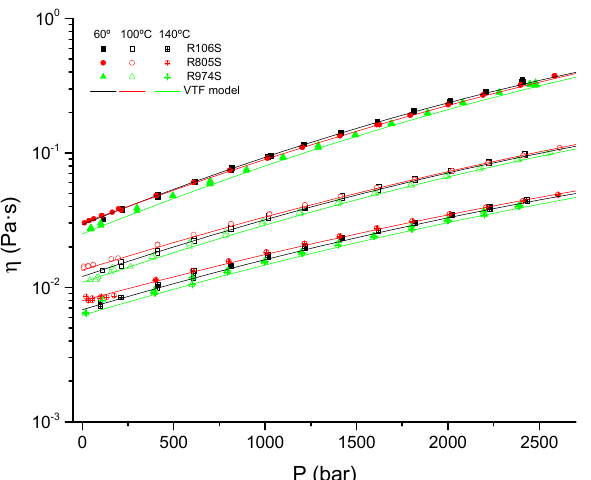
Figure 7. Pressure-viscosity curves for fumed silica suspensions for selected temperatures.